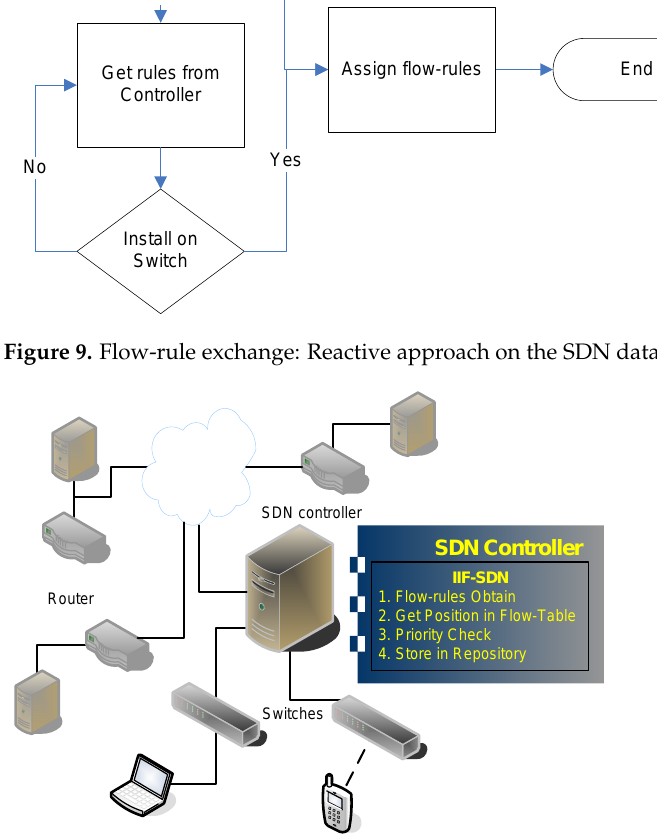
Figure 10. SDN domain (hosts, switches, controller).